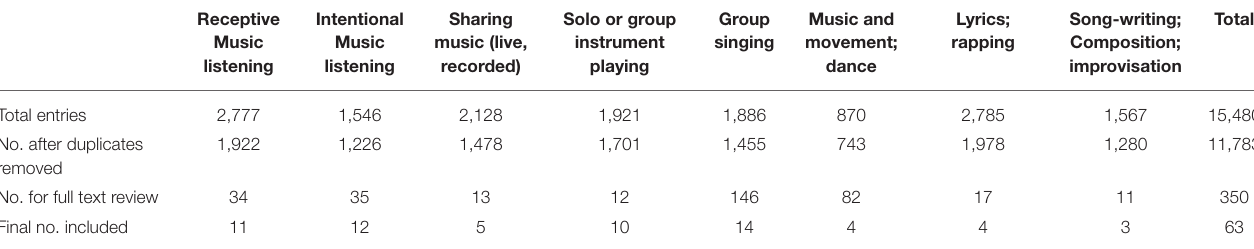
TABLE 1 | Flow of decisions about papers through the abstract screening, quality screening, and full text review process.